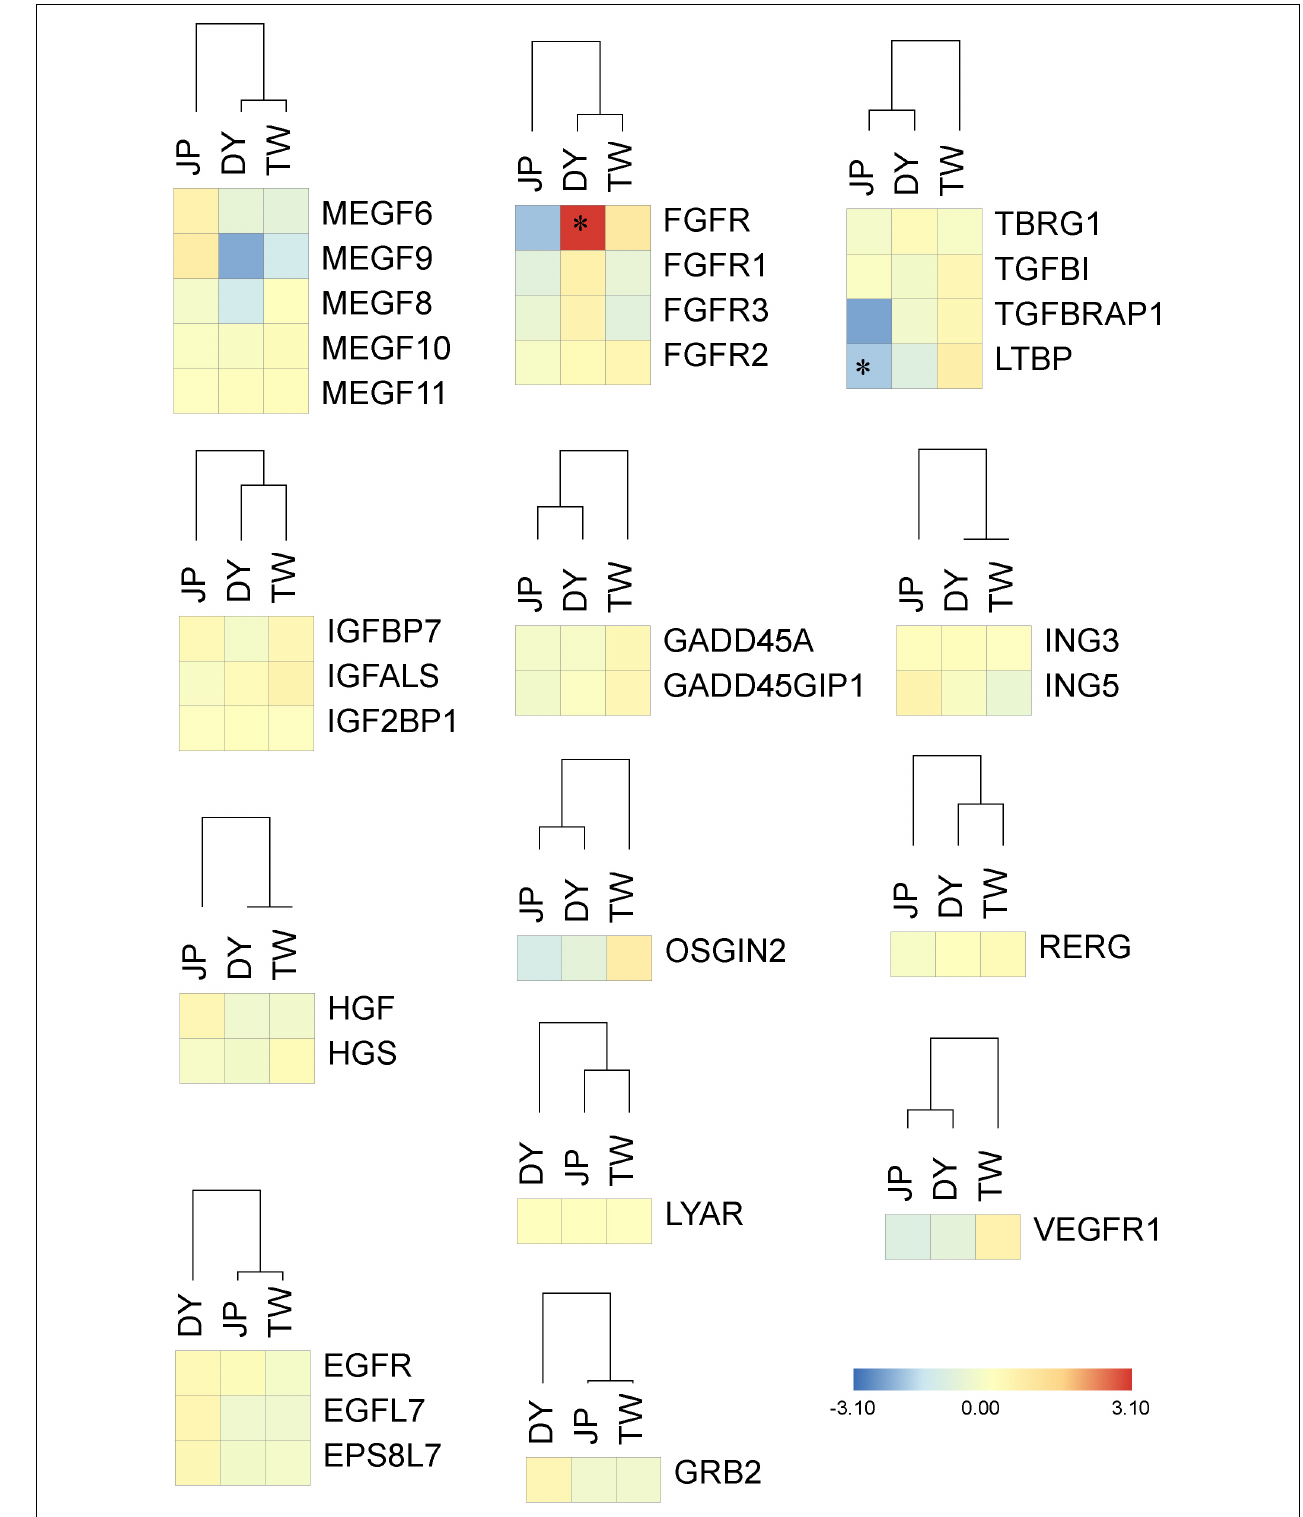
FIGURE 8 | Relative expression of growth-related genes in the three H. diversicolor genotypes. Relative gene expression levels in the three genotypes were normalized to the MPV. Red and blue bars represent up- and down-regulated expression fold change against the MPV, respectively. ∗ represents the significant difference of the gene expression level compared to the